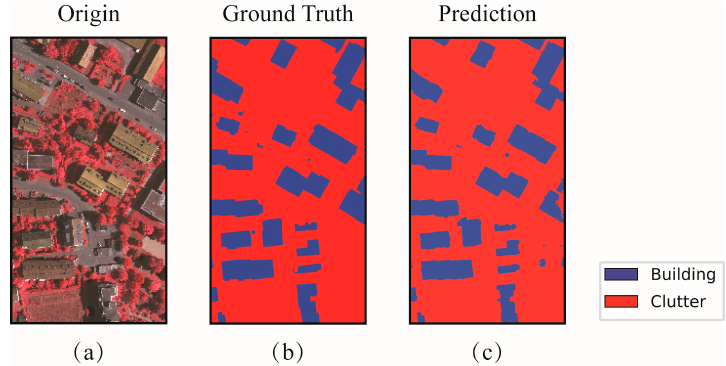
Figure 5. Results of the buildings extraction of the Vaihingen dataset using deep learning, the imagery ( a ) as well as the corresponding ground truth ( b ) and the prediction ( c ).